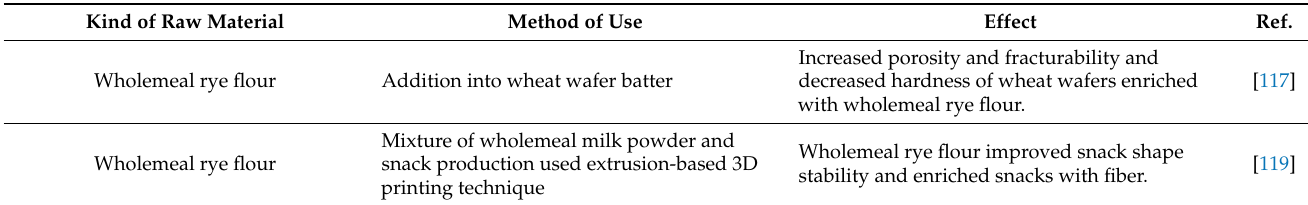
Table 3. Recent trends in the use of rye bran and wholemeal rye flour. Kind of Raw